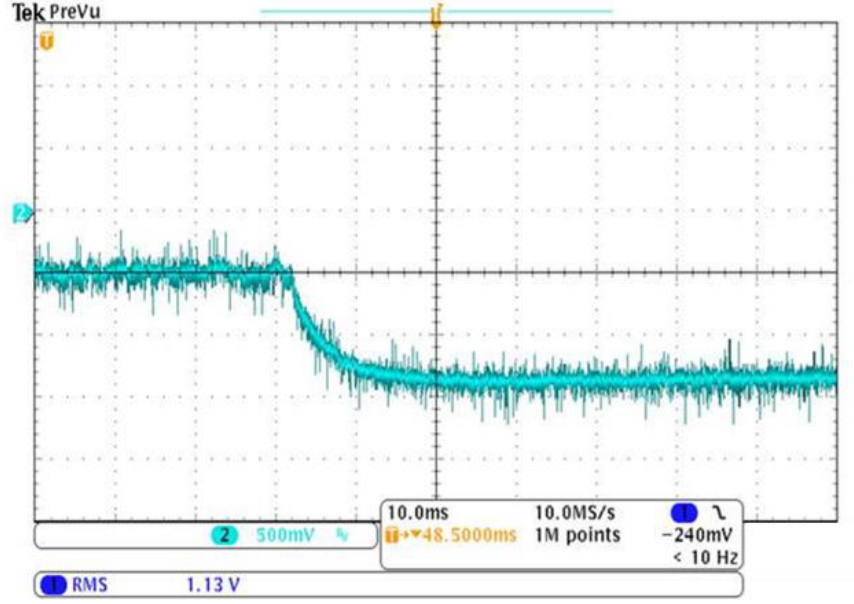
Figure 16. Zoom on a negative bus current transient, responding to an instantaneous negative command.